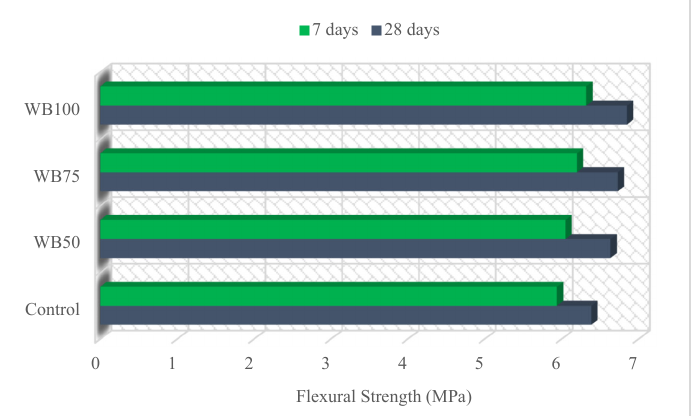
Figure 5. Flexural strength of mixtures.